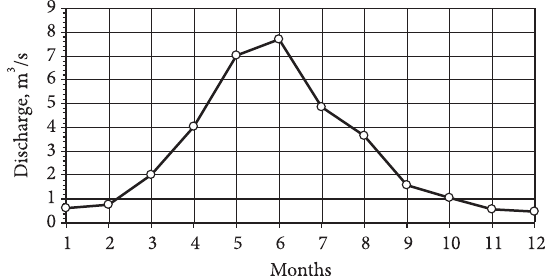
Fig. 5. Long-term mean monthly discharge of Goksu stream (observation period is from 1968